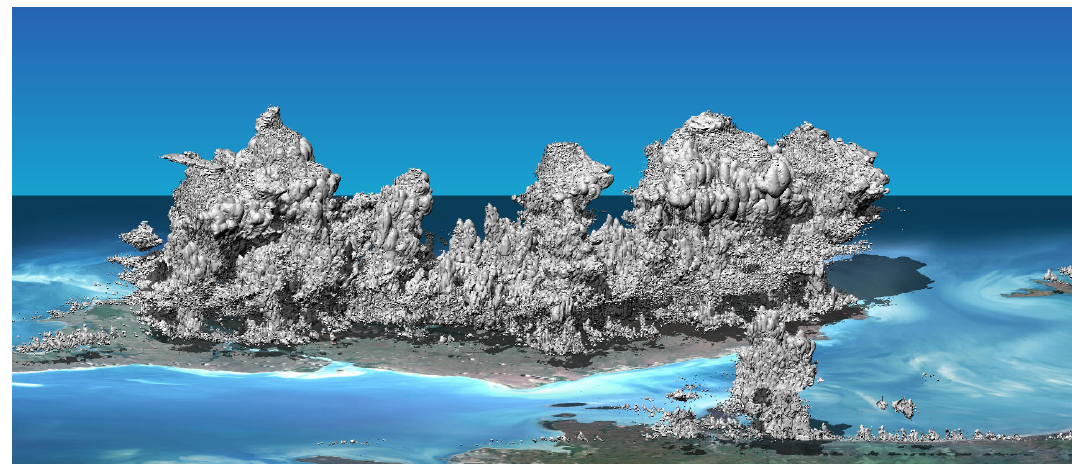
Figure 16. Snapshot of a Meso-NH simulation of Hector the Convector taken from the 1min cloud envelope animation available at https: //youtu.be/xjPumywGaAU (last access: 22 May 2018).